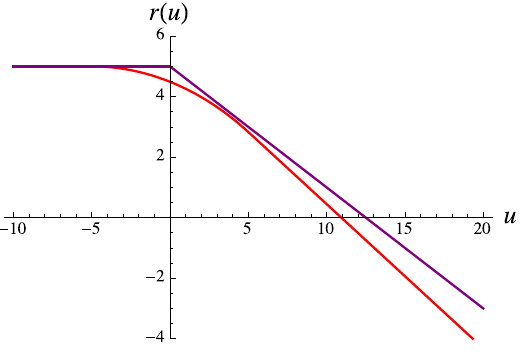
Figure 3 . The (cid:12)nal transverse velocity of the test particle has a memory of the gravitational wave pro(cid:12)le, and is greater for the extended wave burst.